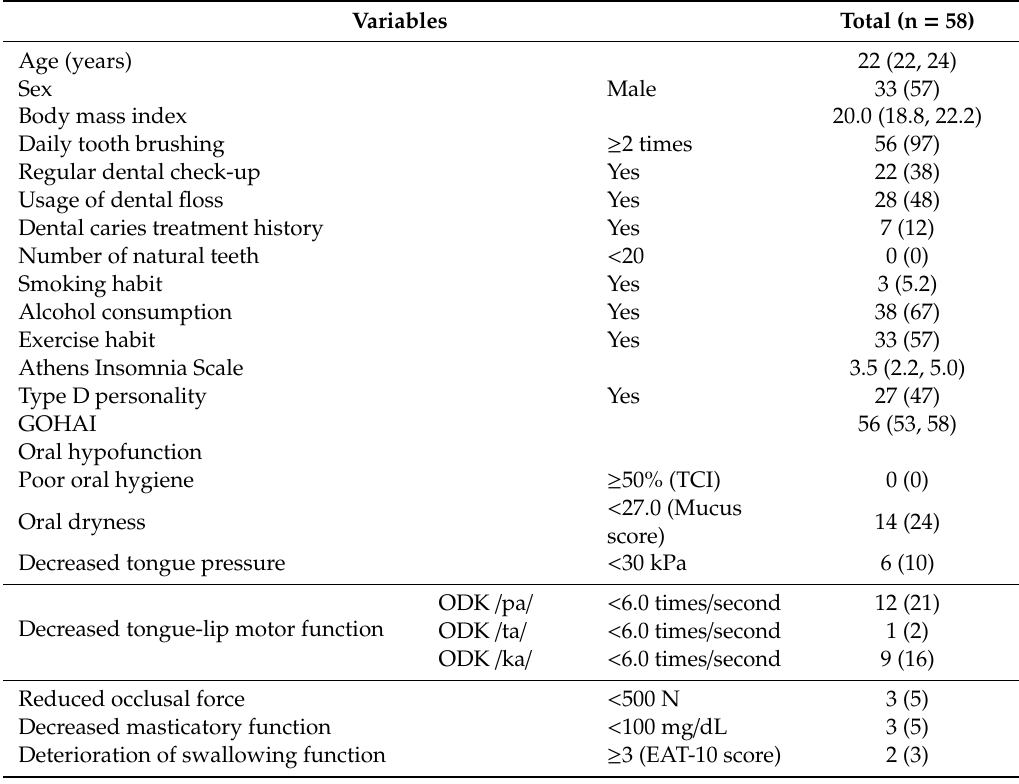
Table 1. Characteristics of the study